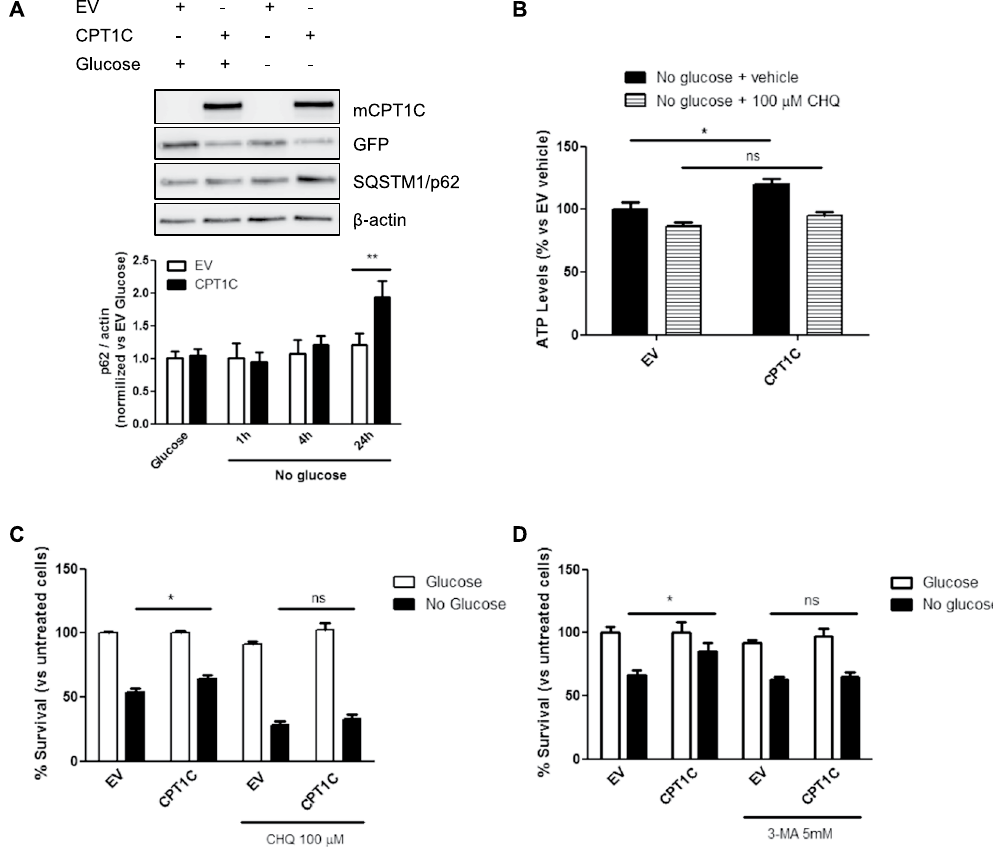
Figure 5. Autophagy inhibition blocks CPT1C protective effects against glucose starvation. ( A ) p62 protein levels were analyzed by immunoblotting in EV or CPT1C-hMSCs at the indicated times after glucose depletion. ( B ) ATP production was evaluated after 36 h of glucose starvation in the presence (last 24 h) or absence of 100 µ M chloroquine. Results are shown as mean ± SEM of 2 independent experiments performed in triplicate. ( C , D ) Cellular viability was measured in EV or CPT1C-hMSCs in the presence or absence of glucose for 72 h with or without the addition of chloroquine (in C ) or 3-MA (in D ) in the last 24 h. Results are shown as mean ± SEM of 3 or 4 independent experiments performed in sextuplet. * p <